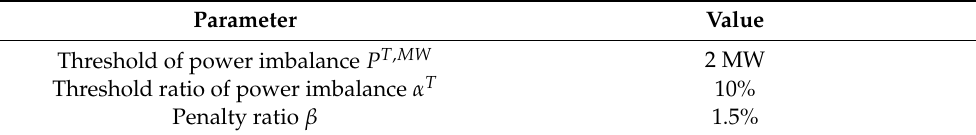
Table 4. Parameters in basic study.